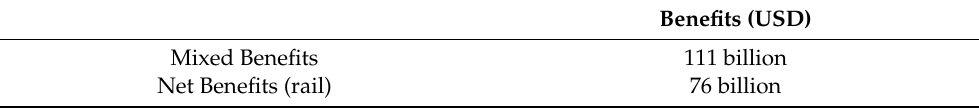
Table 2. The benefits of intercity rail speed increase project